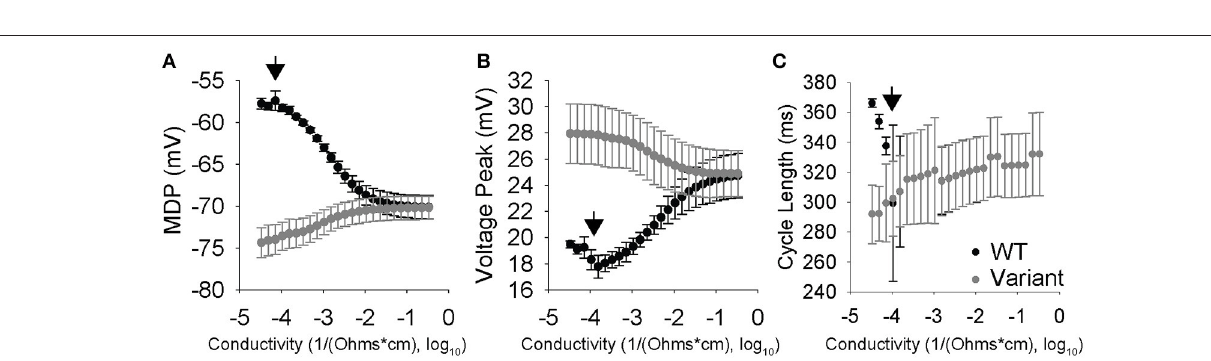
FIGURE 6 | Conductivity vs. cell properties for two coupled SAN cells where one cell was perturbed lognormally, while the other cell is a WT. Data points are the average of 20 simulations with the error bars corresponding to one standard deviation. (A) Max diastolic potential vs. Conductivity. Max diastolic potential synchronizes at higher conductivities and the means become equal around 10 − 1.6 1/ (cid:127) -cm. Larger standard deviations are observed around 10 − 4 1/ (cid:127) -cm. (B) Peak voltage vs. conductivity. Peak voltage equalizes at higher conductivities and the means become equal around 10 − 1 1/ (cid:127) -cm. Larger standard deviations are observed in the 10 − 4 and 10 − 3 1/ (cid:127) -cm range. (C) Cycle Length vs. Conductivity. Cycle length synchronization happens at much lower conductivities than the others, with the means equalizing between 10 − 4 and 10 − 3 1/ (cid:127) -cm. It is in this range that the cells are highly interactive but not fully able to synchronize, which is indicated by large standard